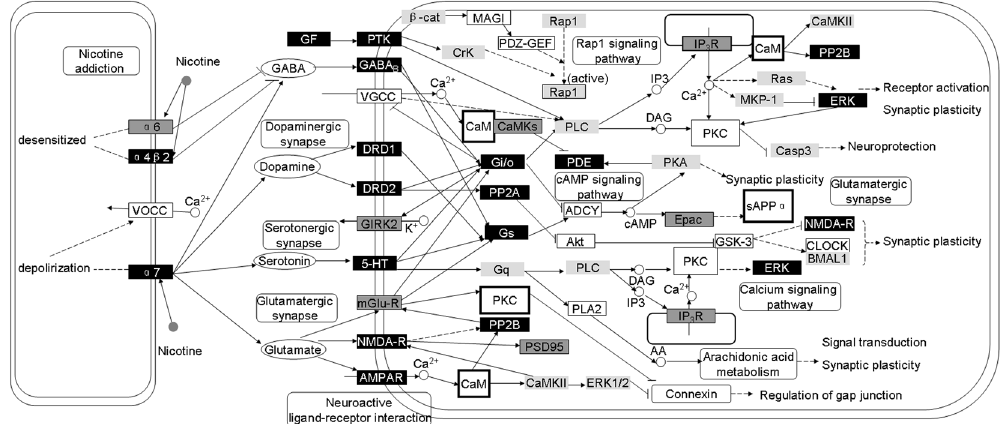
Figure 2. A systematic network of the molecular mechanism underlying schizophrenia and nicotine addiction. This network was built based on the results of pathway analysis and network analysis. Nodes shown in white, grey, and black rectangles represent genes related to schizophrenia, nicotine addiction, or both diseases, respectively. The predicted candidate genes are shown by larger rectangles with bold border. Ellipses represent neurotransmitters like GABA, serotonin, dopamine and glutamate. Dashed and solid lines represent indirect and direct regulations; lines with arrow and spot represent activation and inhibition,